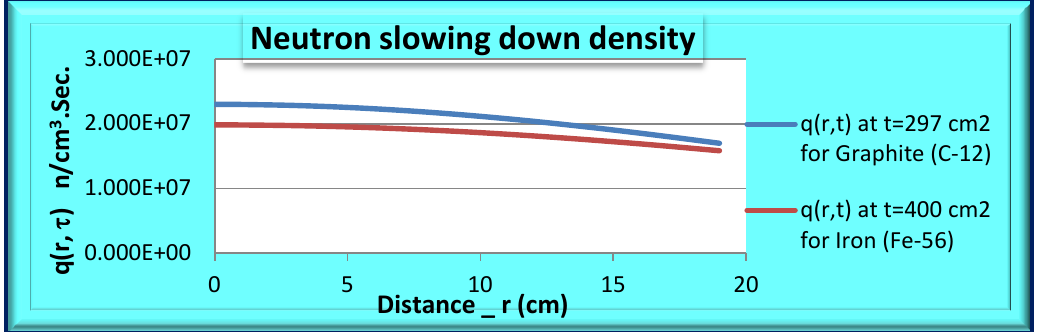
Fig.4:Fermi Age for Iron material using the activation of Indium foil technique.